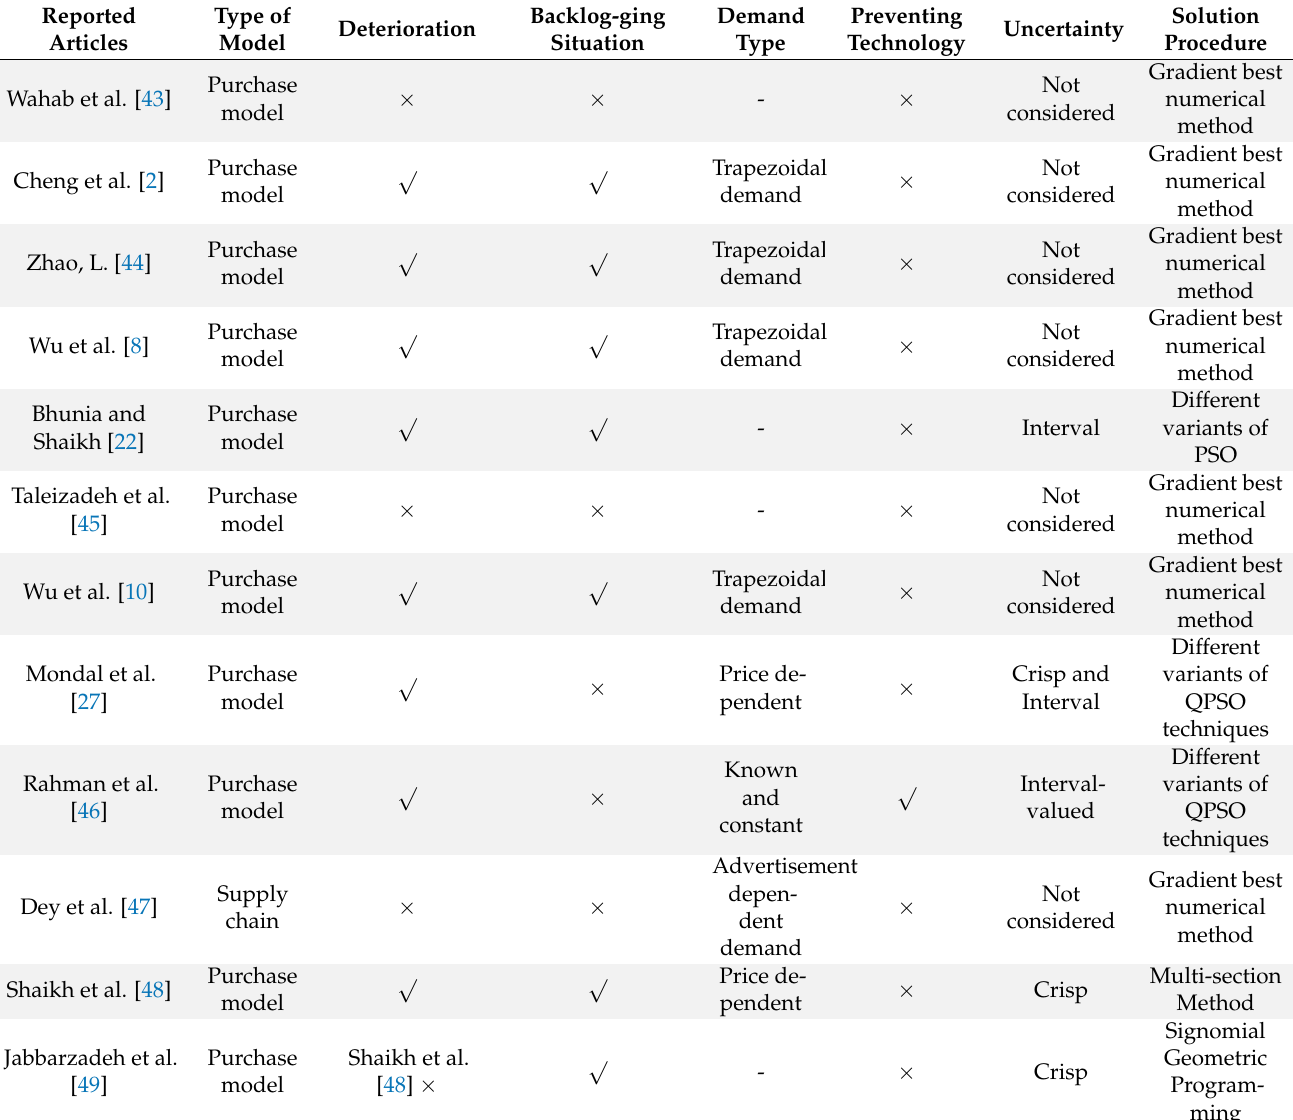
Table 1. Literature review related to the proposed